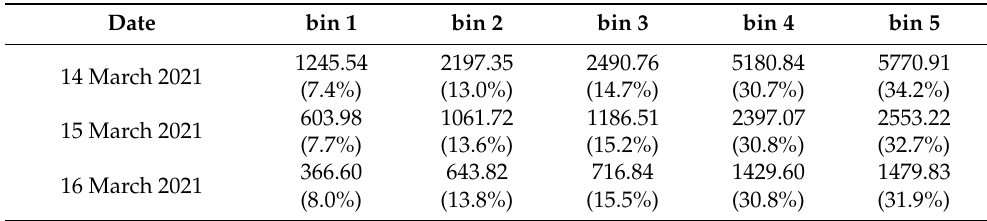
Table 2. Daily accumulated dust emissions (kt) and the percentage of daily total dust emissions in dust size bin 1 1–5. Date